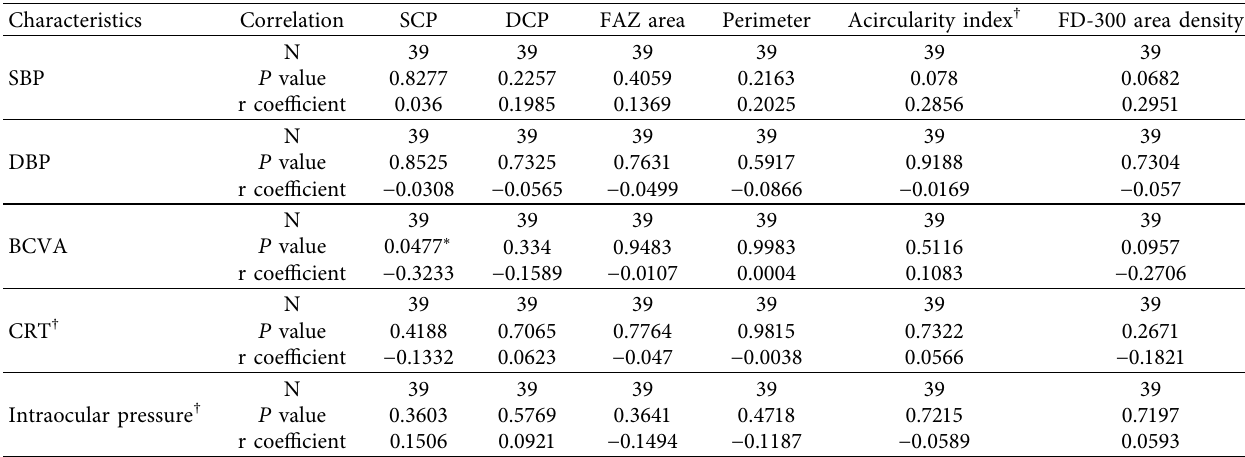
Table 5: Correlations between BCVA, CRT, intraocular pressure, SBP, DBP, and indexes of macular vascular density at month 12. Characteristics